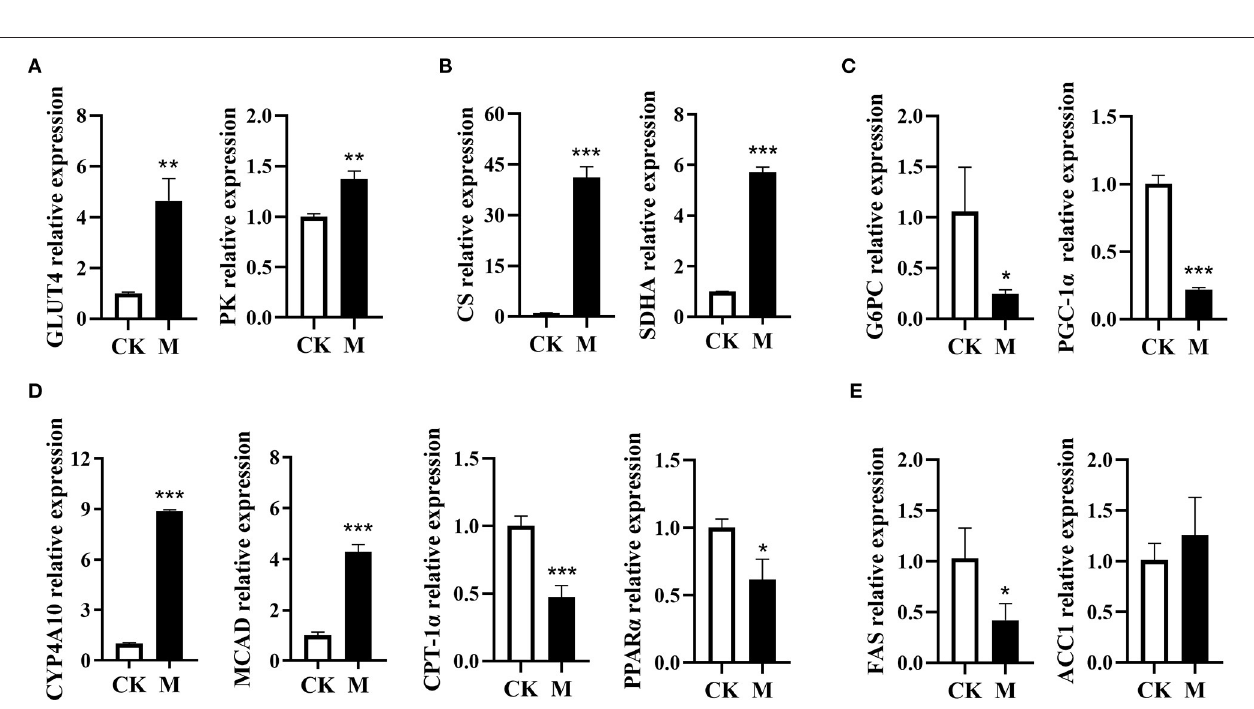
FIGURE 2 | Expression profiling of genes encode the enzymes in metabolic pathways in the splenic B cells post EgPSC infection. B cells were obtained from the spleens of control or EgPSC infected mice, and the mRNA expression of the genes encode the enzymes in metabolic pathways was characterized by RT-PCR. (A) GLUT4 and PK, (B) CS and SDHA, (C) G6PC and PGC-1 α , (D) CYP4A10, MCAD, CPT-1 α , and PPAR α , and (E) FAS and ACC1. Values are mean ± standard error of means. n = 4-5 mice per group. CK, control check group; M, model group; GLUT4, glucose transporter 4; PK, pyruvate kinase; CS, citrate synthase; SDHA, succinate dehydrogenase complex subunit A; G6PC, glucose-6-phosphatase; MCAD, medium-chain acyl-CoA dehydrogenase; CYP4A10, cytochrome P450 proteins 4; CPT-1 α , carnitine palmitoyl transferase 1a; PPAR α , peroxisome proliferator–activated receptor α ; PGC-1 α , peroxisome proliferator–activated receptor- γ coactivator1 α ; FAS, fatty acid synthase; ACC1, acetyl coenzyme A carboxylase 1 (Student’s t -test: * P < 0.05, ** P < 0.01, *** P <